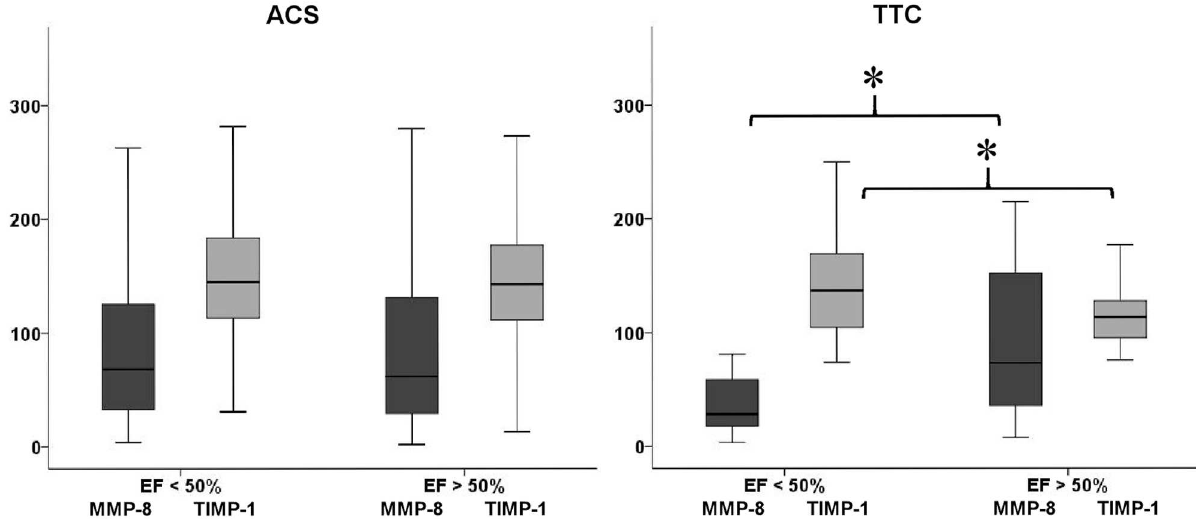
Fig 2. In acute coronary syndrome and Takotsubo Cardiomyopathy (TTC) patients, Matrix Metalloproteinase-8 (MMP-8) and Tissue Inhibitor of Matrix Metalloproteinase-1 (TIMP-1) levels stratified by Ejection Fraction (EF). In TTC, MMP-8 and TIMP-1 levels also reflect ventricular impairment. Data in box-plotsare presented as medians,25th and 75th percentiles(boxes), and 10th and 90th percentiles(whiskers). * p = 0.01.